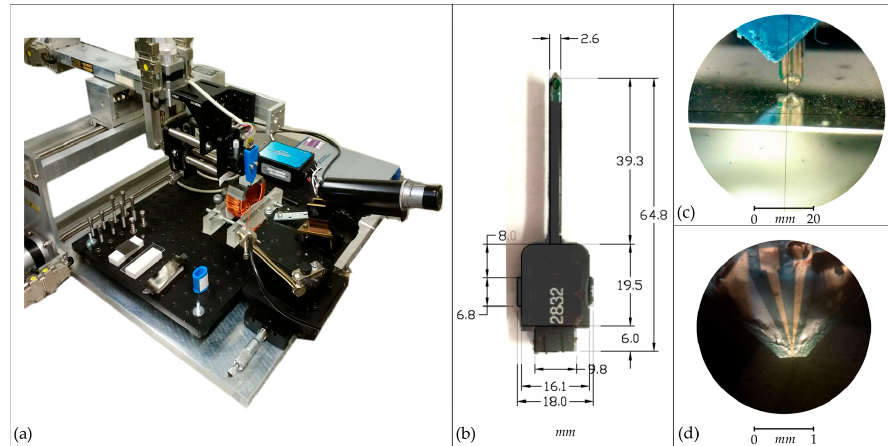
Figure 2. The magnetic field imaging system: ( a ) Built around a three-axis Parker Automation positioning arm (Parker Hannifin Corp, Cleveland, OH, USA), 3D-printed sensor enclosure, precision goniometer, and incorporated microscopic sight; ( b ) The Micromagnetics ® STJ-020 tunneling magneto-resistance (TMR) sensor long-probe packaging (Micromagnetics Inc., Fall River, MA, USA); ( c ) The enclosed STJ-020 TMR sensor positioned perpendicular above a sample of (polished) grain-oriented electrical steel (minimum scanning height z 0 = 12 µm ± 3 µm); ( d ) The Micromagnetics ® STJ-020 sensor die with the tip refined to a 7.0 µm ± 0.5 µm tip-edge-to-active-area distance.